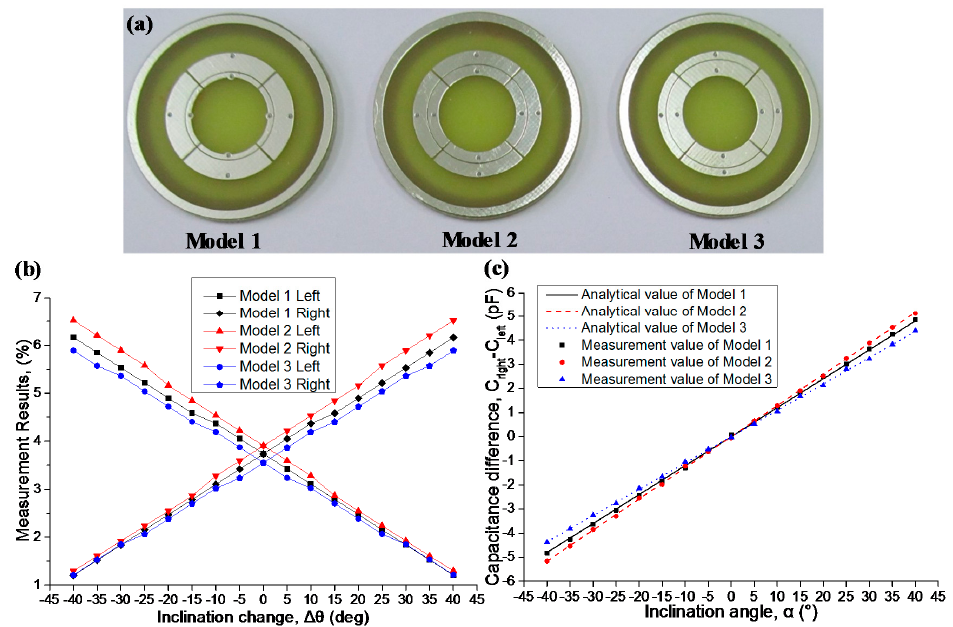
Figure 8. ( a ) three models with different structure parameters; ( b ) percentage change of C right and C left respect to the inclination change in three models; ( c ) corresponding sensitivity comparison results.